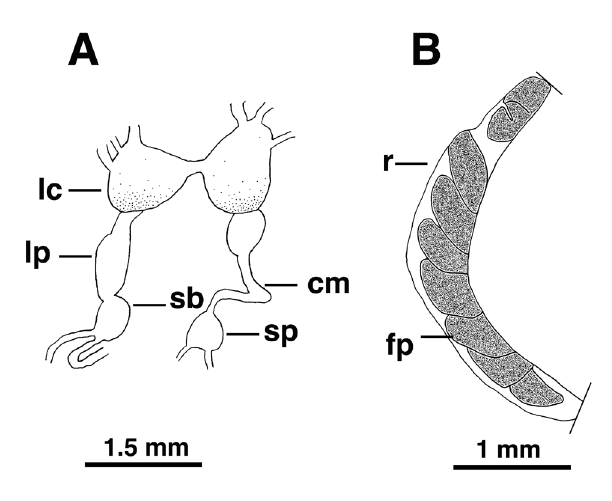
Figure 5. Non-genital anatomy of Dianella schlickumi . A Nervous system B Rectum full of faecal pellets. Abbreviations: cm -commissure; fp -faecal pellets; lc -left cerebral ganglion; lp -left pleural ganglion; sb - suboesophageal ganglion; sp -supraoesophageal ganglion; r Table 3. Average (±standard error) and range (minimum and maximum values) of the morphometric measurements (in mm) taken in Dianella thiesseana and Dianella schlickumi specimens . The results of t-test are also provided (* indicates the significant differences). n = number of individuals used: H: shell height; W: shell width; Ha: shell aperture height; Wa: shell aperture width; SH: spire height; BWH: body whorl height; PWH: penultimate whorl height.